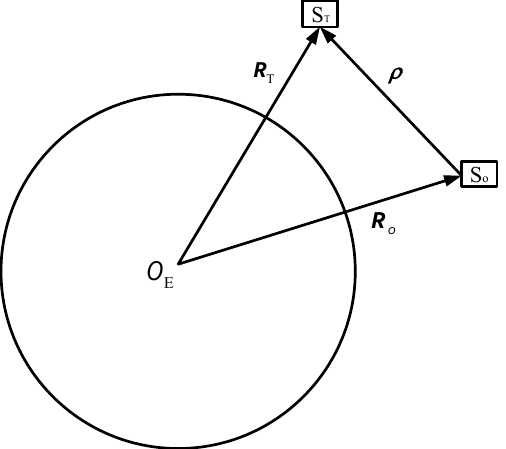
Figure 2. The Position Vector from the Observer to the